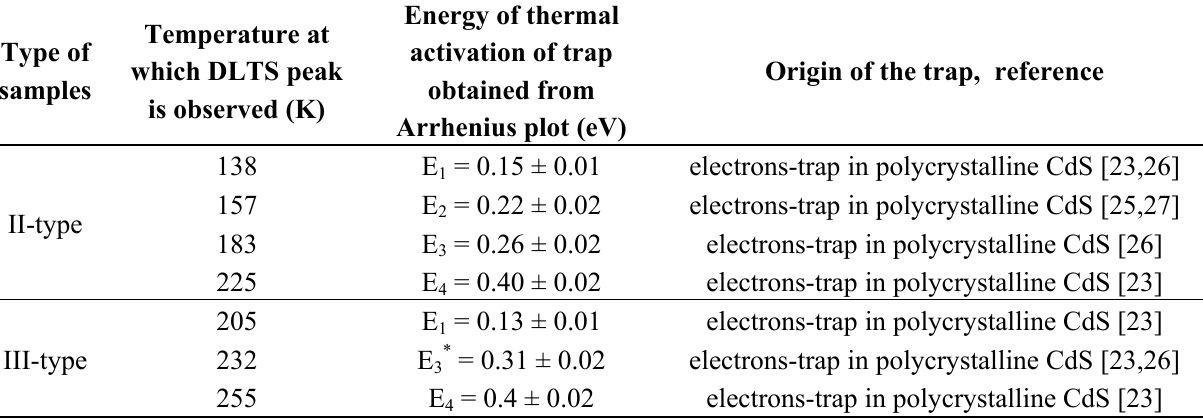
Table 1. Deep level transient spectroscopy (DLTS) peaks obtained within the spectra of different types of